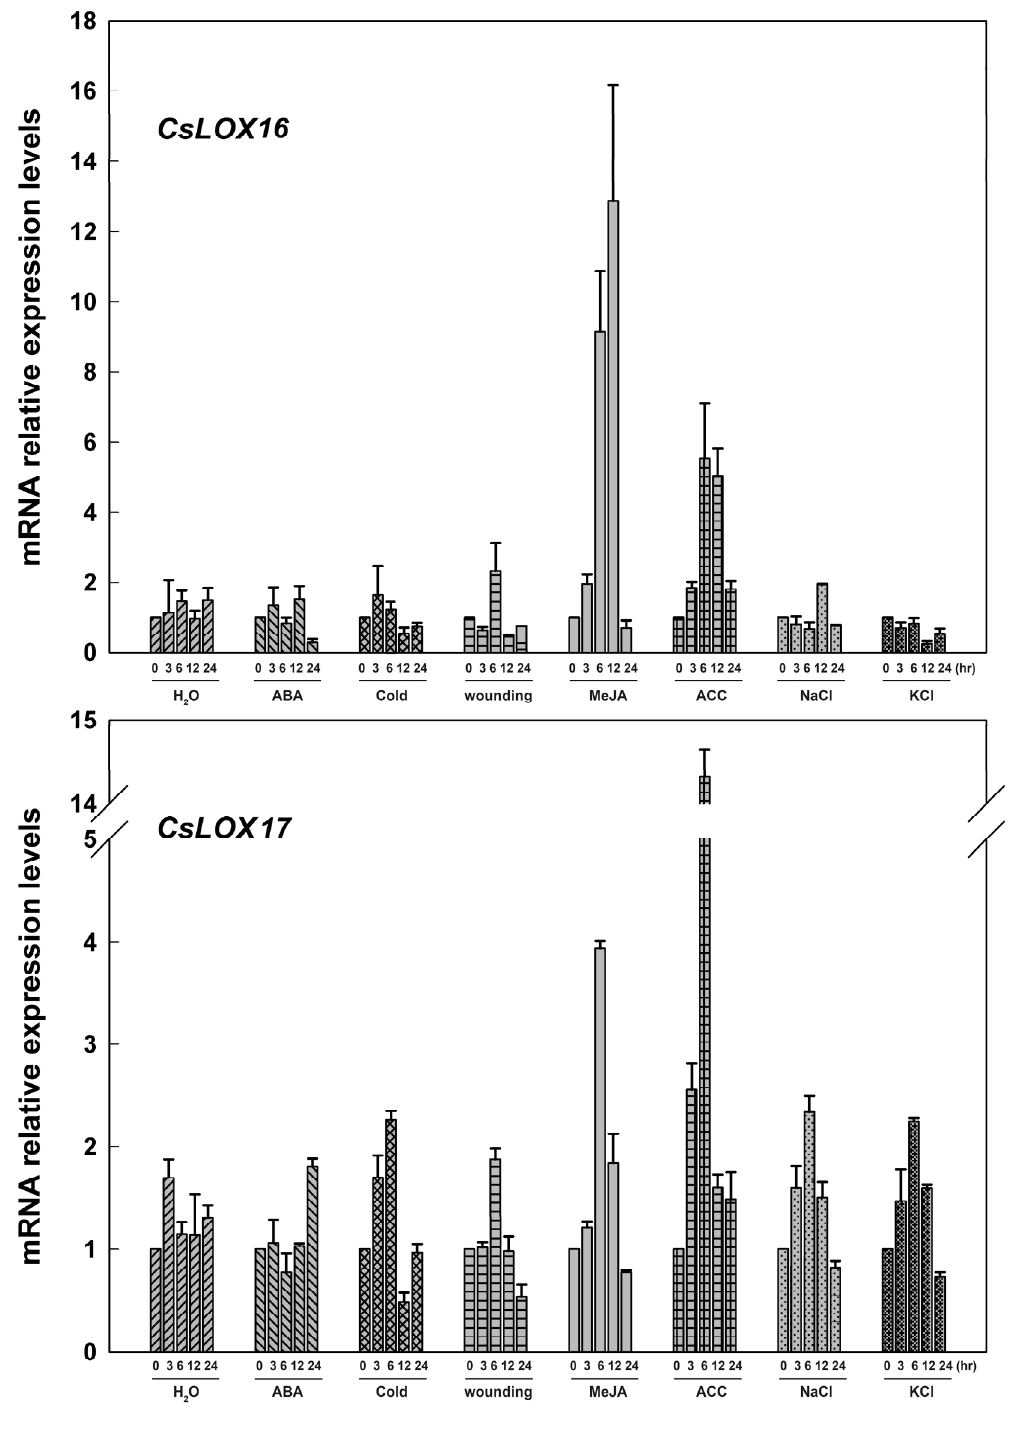
Figure 7. Expressions of CsLOX16 and CsLOX17 in cucumber leaves at various time points under treatments with H O, ABA (100 μ M), cold (4 °C), wounding, MeJA (100 μ M), ACC 2 (100 μ M) NaCl (200 mM) and KCl (200 mM) were analyzed by Real-time PCR. A cucumber actin gene CsACT (Csa017310) was detected as internal reference. Data represent the mean ± SD of three independent biological